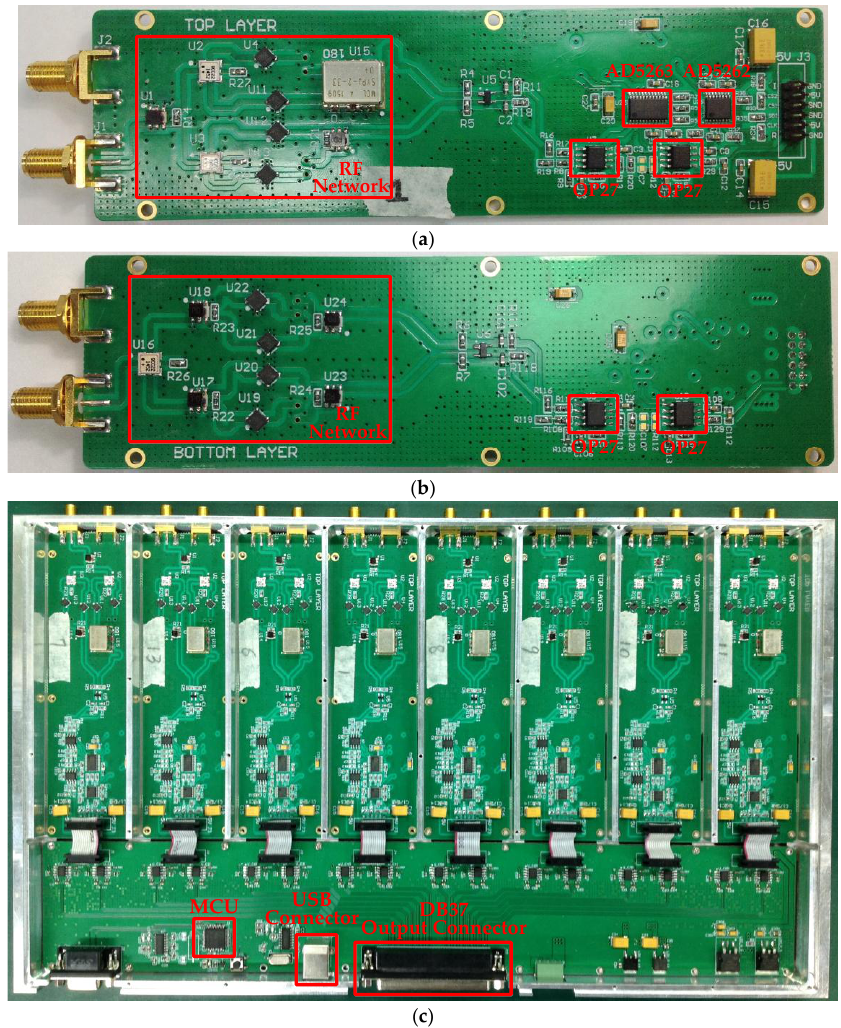
Figure 6. Photographs of the experimental analog complex cross-correlator: ( a ) Top layer of a correlator board; ( b ) bottom layer of a correlator board; and ( c ) eight-channel correlator module.